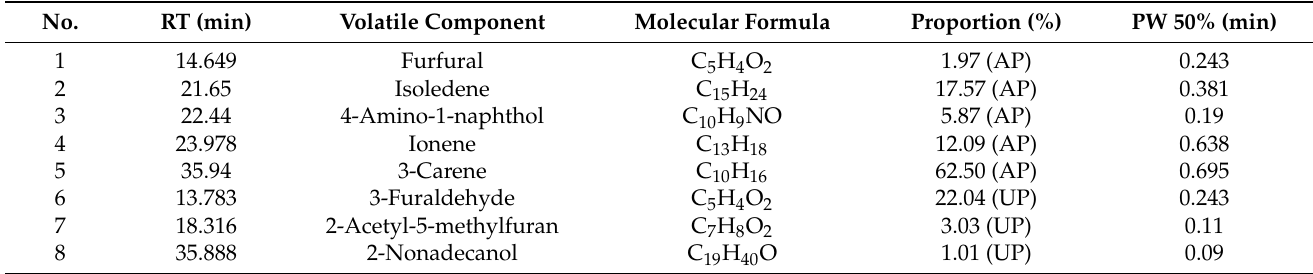
Table 1. Volatile components of D. crassirhizoma determined with HS-SPME-GC-MS